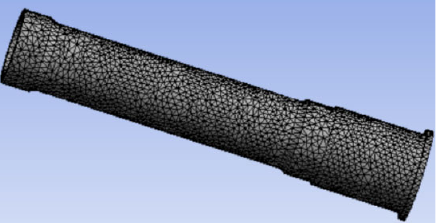
Figure 5. Finite element analysis model of the big arm.